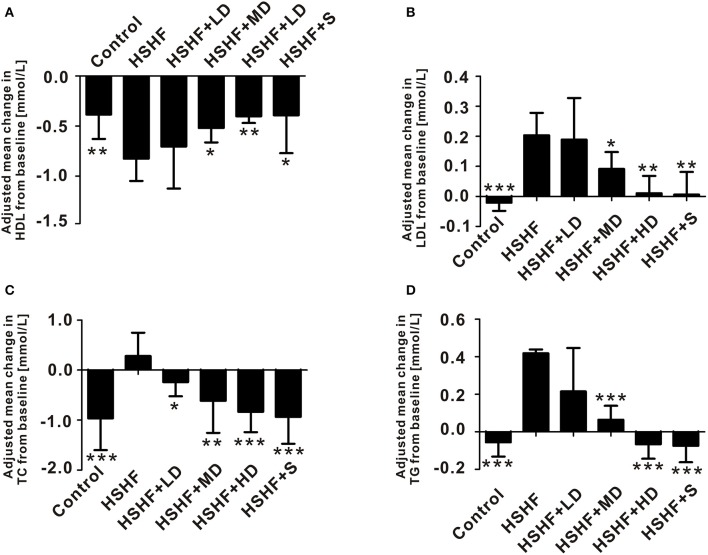
Krill oil significantly improved serum lipid control in mice fed the HSHF diet. (A) Change in the HDL level. (B) Change in the LDL level. (C) Change in the TC level. (D) Change in the TG level. Data are presented as the means ± S.D. Differences were assessed by ANOVA. *P < 0.05, **P < 0.01, and ***P < 0.001 vs. HSHF group.